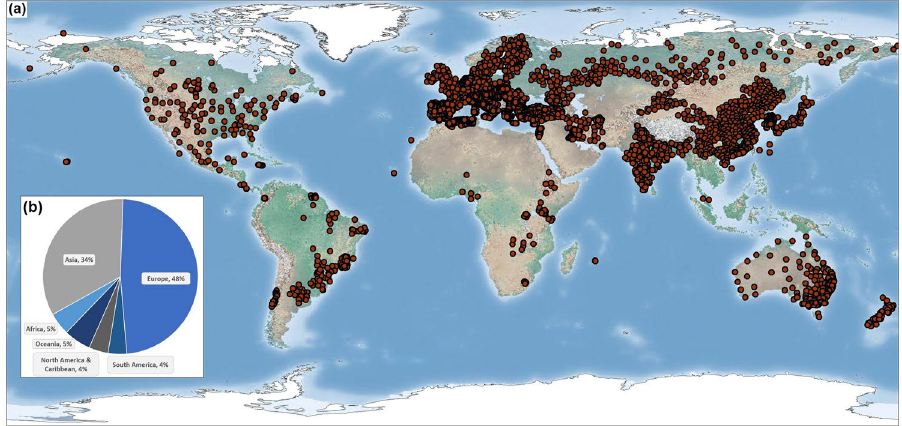
Figure 1. ( a ) Global distribution of rainfall erosivity stations (red dots) compiled in the Global Rainfall Erosivity Database (GloREDa); ( b ) Distribution of rainfall erosivity stations by continent. Maps generated with ESRI ArcGIS ver. 10.4